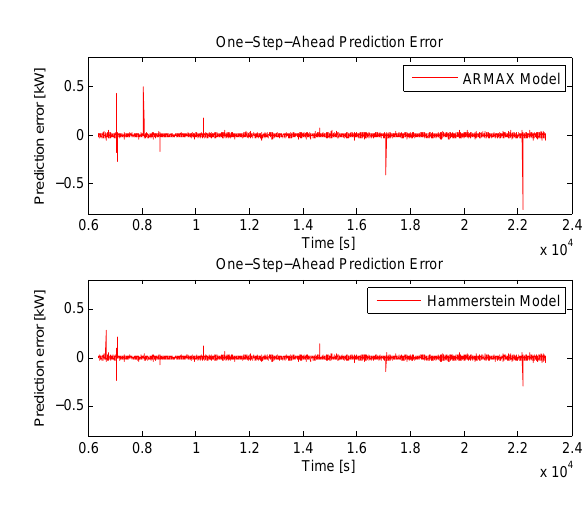
Figure 18: One-step-ahead prediction error, e , of the linear ARMAX model identified in Section 6 (upper) and the Hammerstein model of (30)